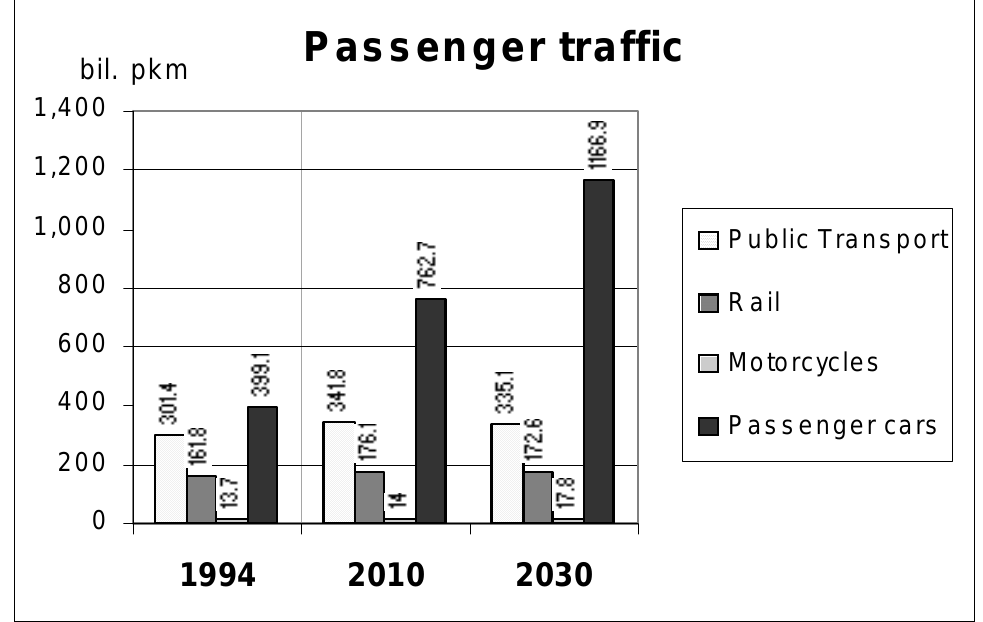
Figure 2. Current and projected modal split for passenger transport in the CEI